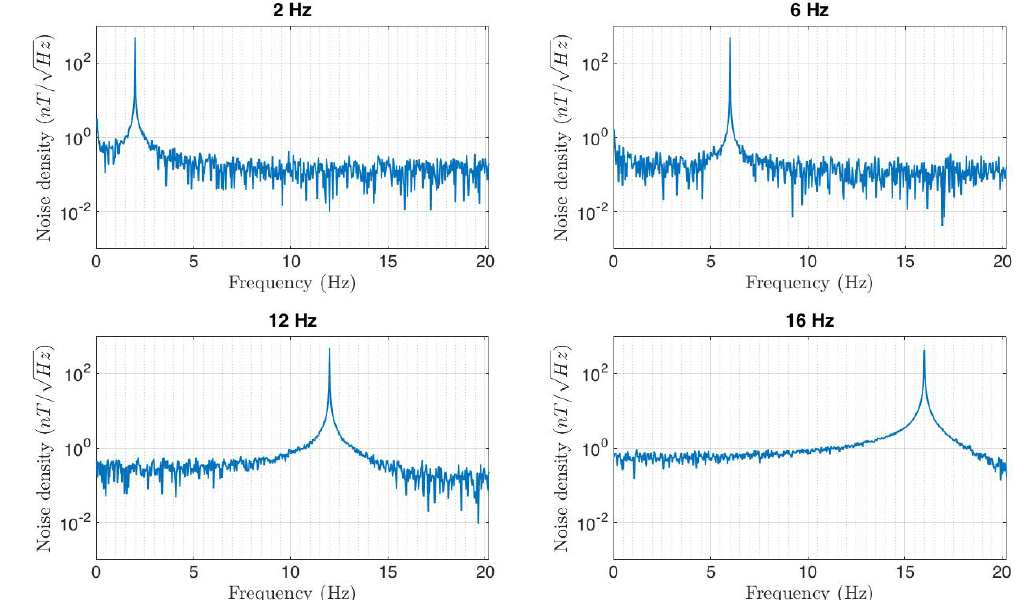
Figure 12. Noise density plots for four different frequencies of the input signal.